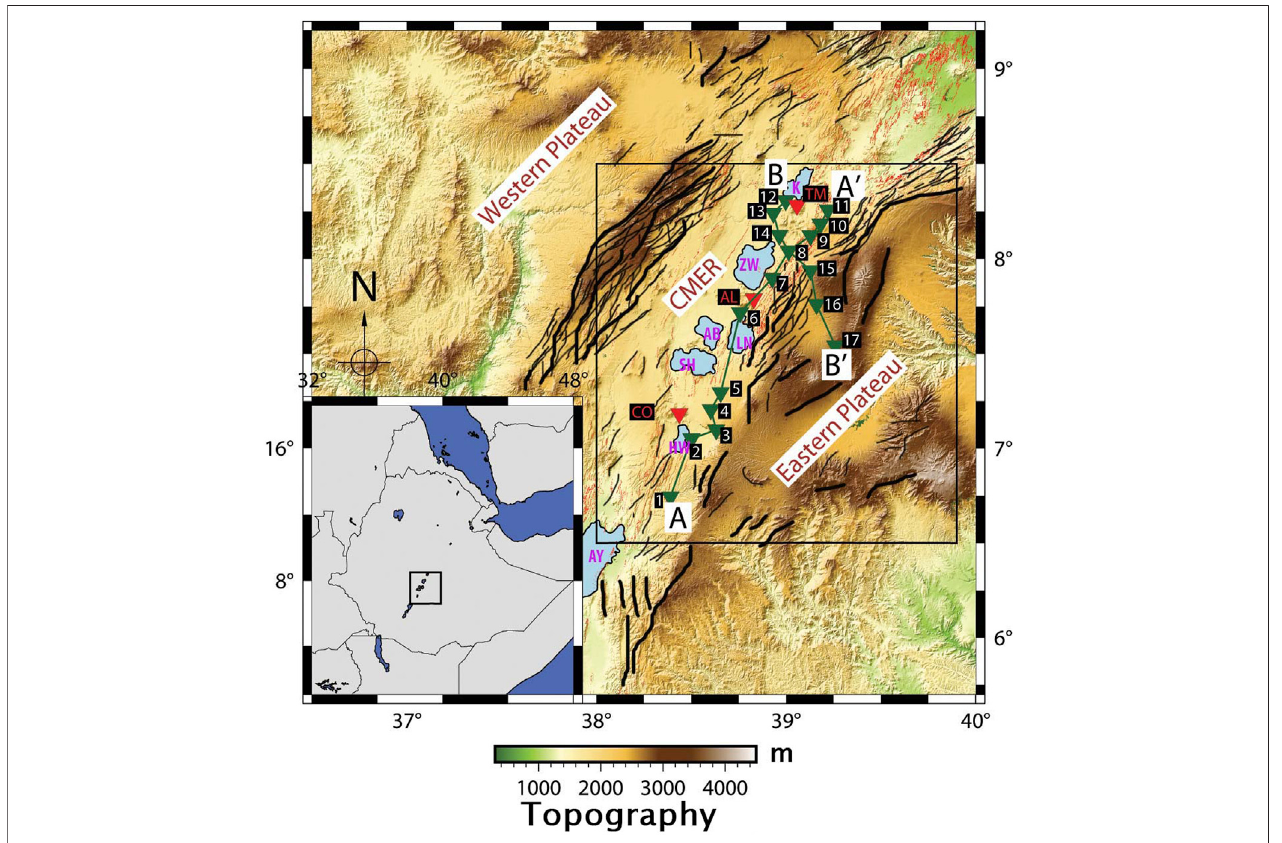
FIGURE1| TheblackrectangleisthestudyareaintheCentralMainEthiopianRift.Pro fi leAA ′ isalongtheeasternsideoftheCentralMainEthiopianRift fl oor(along- rift) pro fi le. Pro fi le BB ′ is the across-rift pro fi le. Green reversed triangles represent the station location of 17 stations. Red -reversed triangles represent the locations of Corbetti (CO), Aluto (AL), and Tulu Moye (TM) calderas. The red thin and dense line represents the faults of the Main Ethiopian Rift (MER) (Corti et al., 2020). The bottom left corner inset shows the regional map, with a square for the area of our study. Names of the lakes are labelled by pink-coloured letters as AY (Abaya), HW (Hawasa), SH (Shala), AB (Abayata), LN (Langano), ZW (Ziway), and K (Koka).